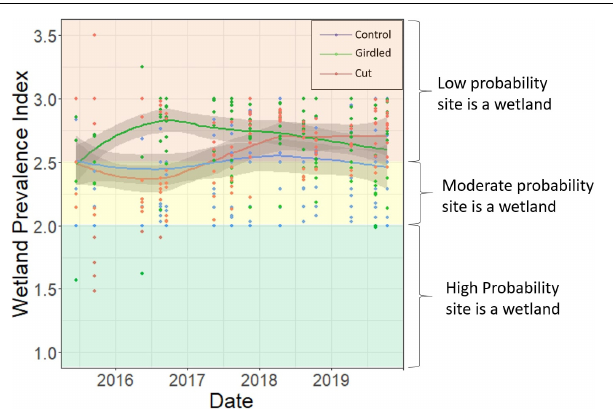
FIGURE 7 | Change in Wetland Prevalence Index (PI) over time in upland elevation bins 1 and 2, color-coded by treatment. PI values greater than 2.5 indicate a low probability a site is a wetland, values between 2 and 2.5 indicate a good probability that a site is a wetland, and values less than 2 indicate a high probability that a site is a wetland. Points represent the PI calculated from each vegetation survey conducted for each single vegetation plot in upland bins 1 and 2. Trend lines depict Loess-smoothed local polynomial regression, with the shaded area around the trend lines showing the standard